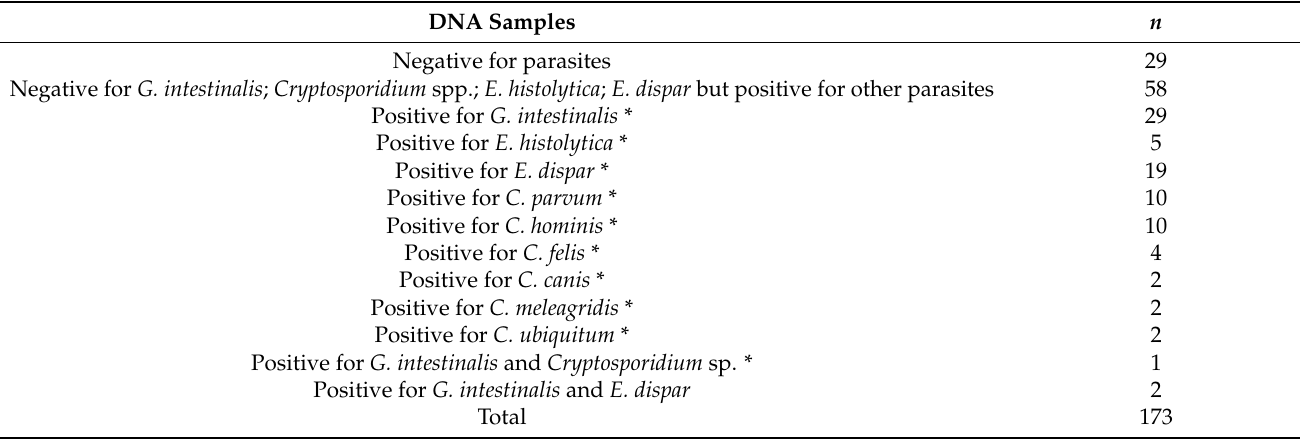
Table 1. DNA samples collected.